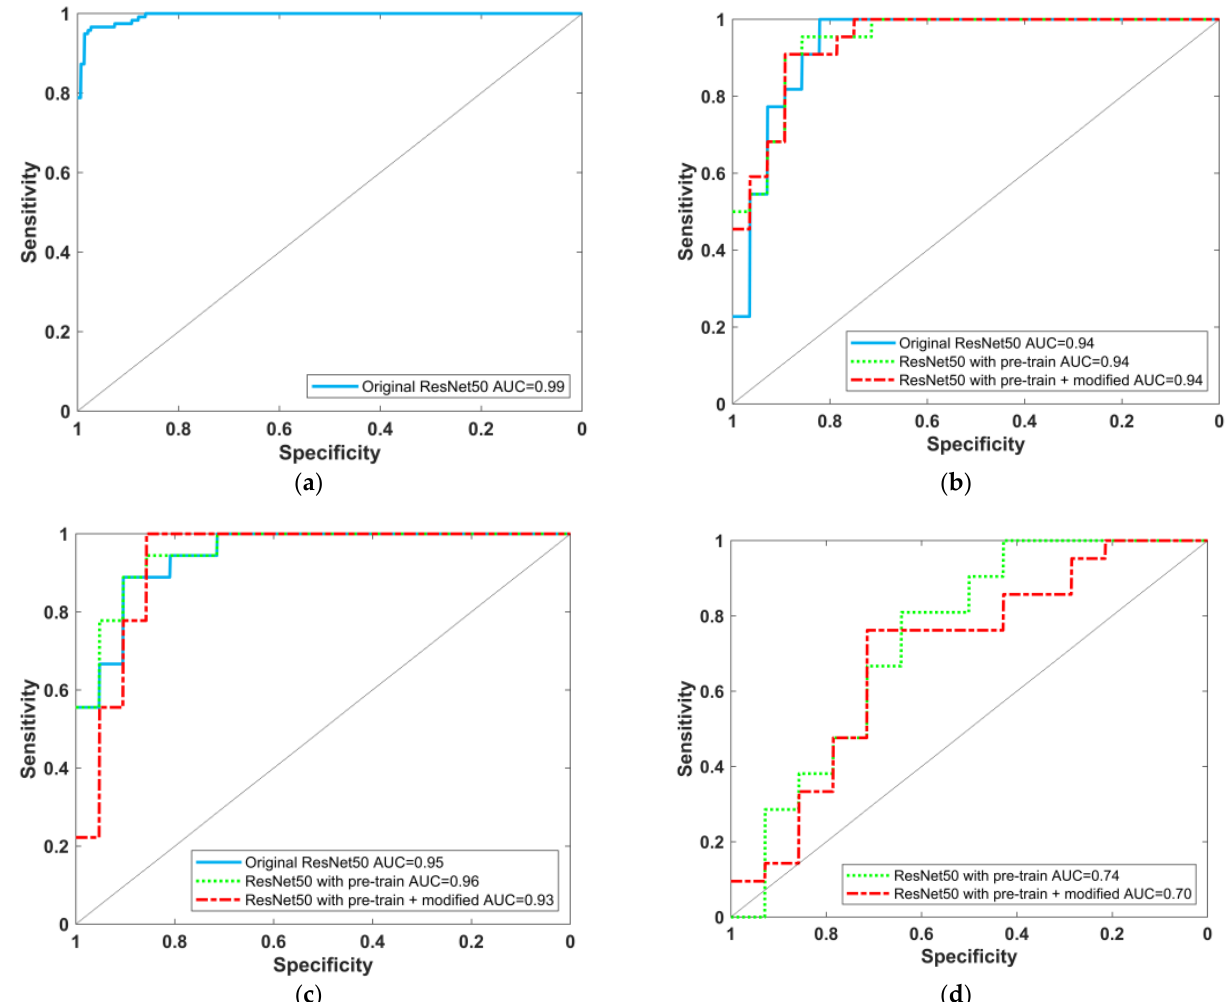
Figure 4. ( a ) ROC curve of ResNet-50 model trained on F-18-FDG PET images for AD/NC; ( b – d ) ROC curves of various deep learning models trained on Tc-99m-ECD SPECT images, ( b ) AD/NC; ( c ) LBD/NC; ( d ) AD/LBD task. Table 4. Comparison of the training performance of ECD data sets in various models for distinguishing between AD and NC.